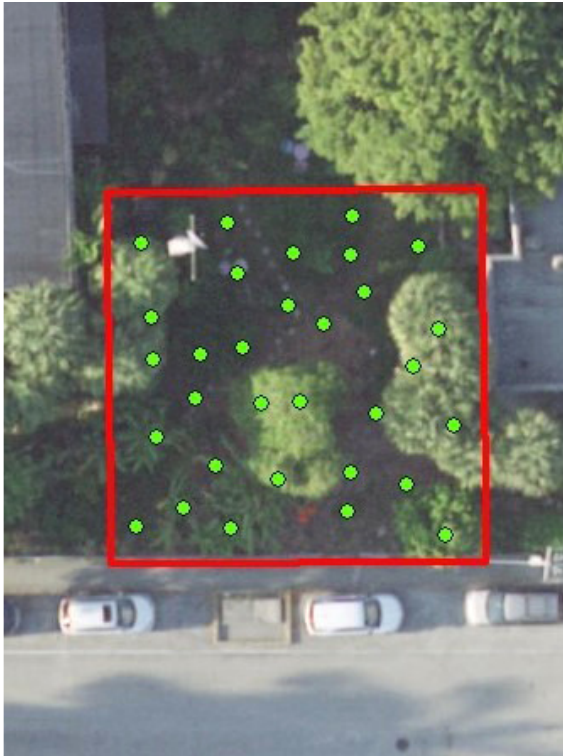
Figure 4. An example of the 30 points that were randomly generated by i‐Tree Canopy tool in the 20 × 20 m